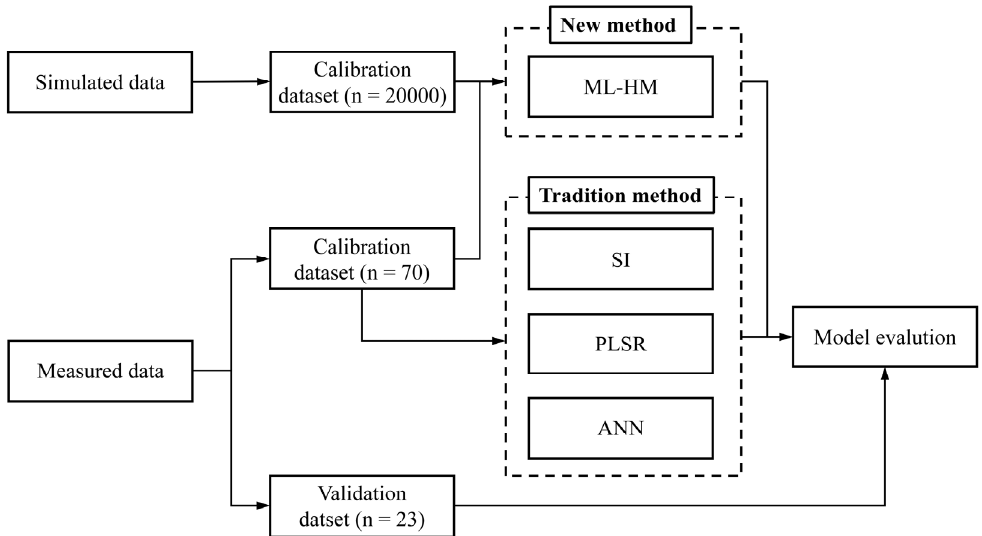
Figure 3. Main flow chart of the LNC prediction models designed based on SI, PLSR, ANN and ML-HM methods.